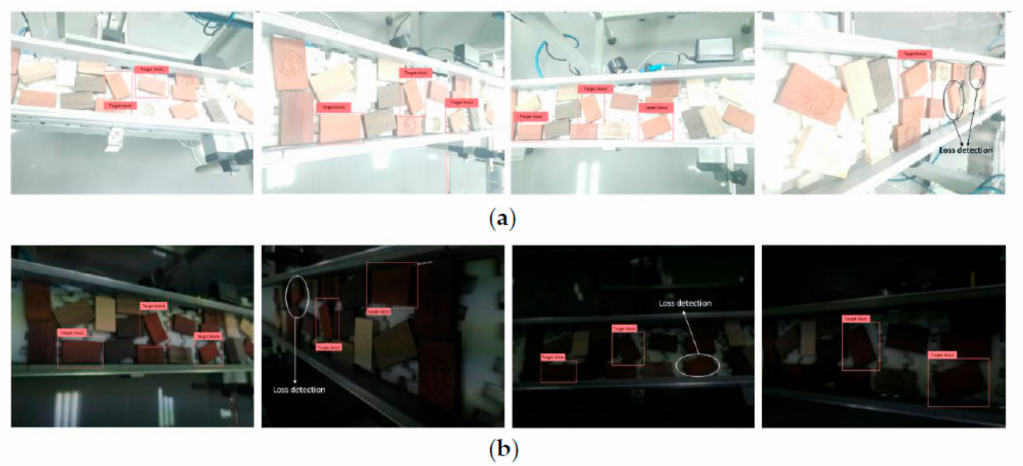
Figure 12. Target recognition results under di ff erent ambient light conditions. ( a ) The recognition of the complex background targets under strong illumination. ( b ) The recognition of complex background targets under low illumination.